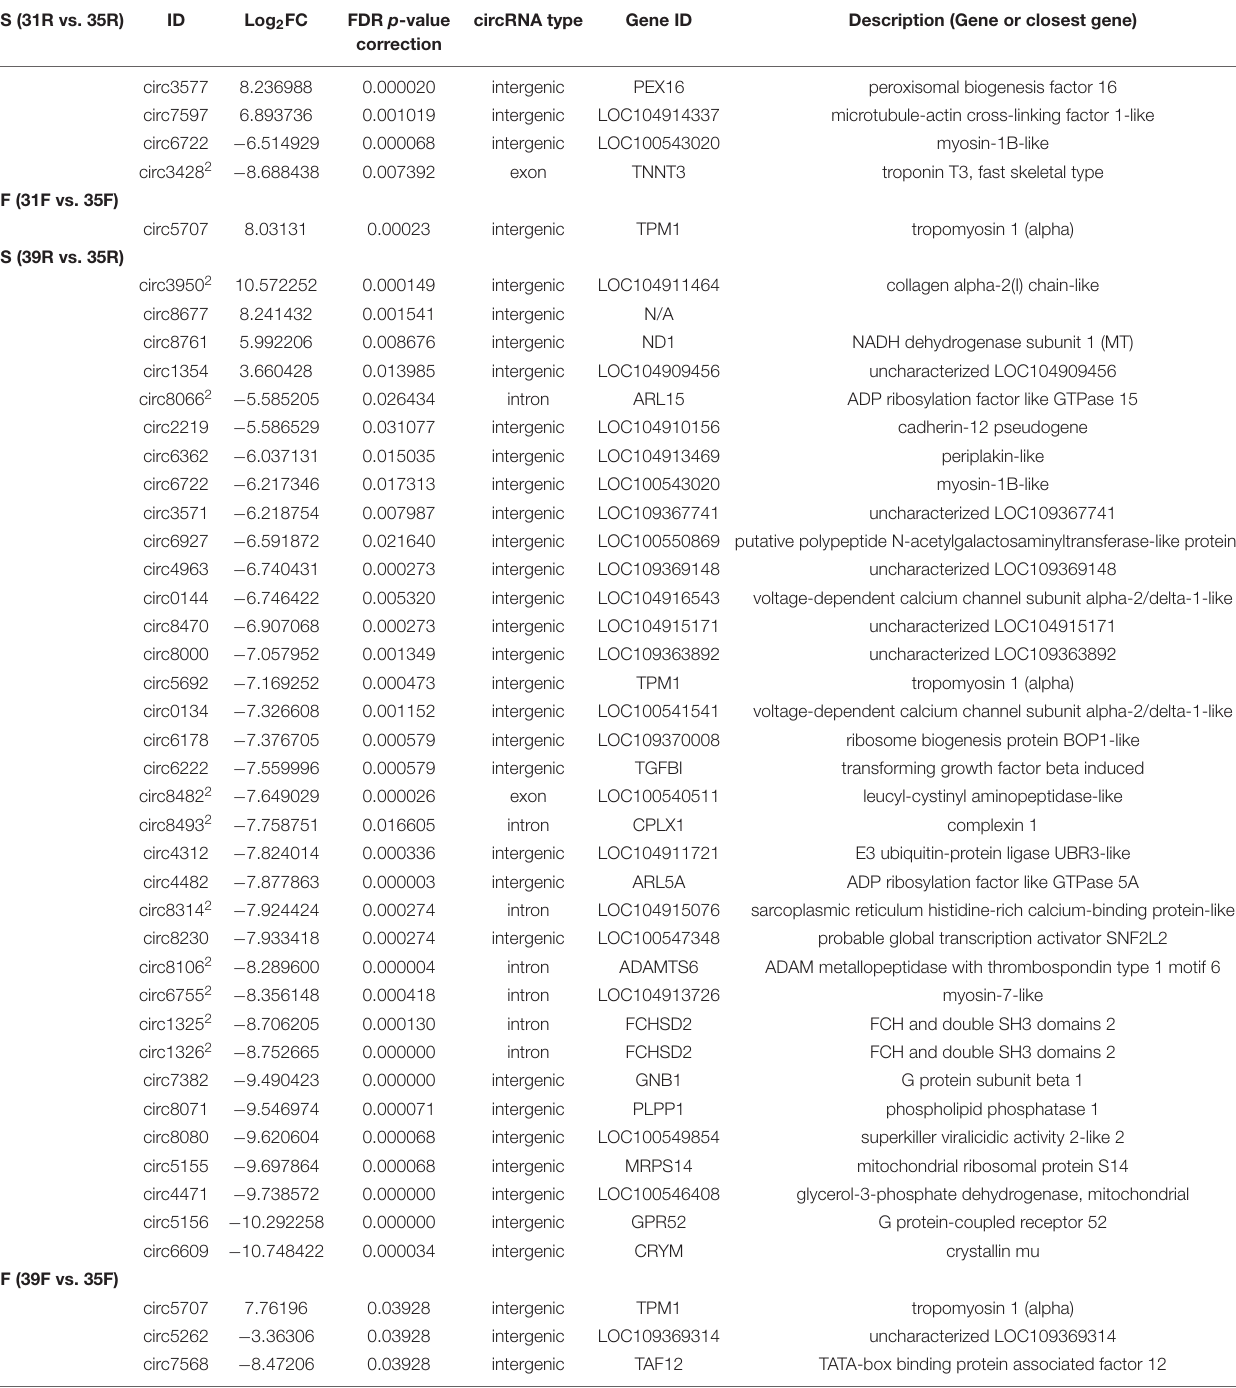
TABLE 3 | Significant differentially expressed circRNAs (FDR P < 0.05 and | Log 2 FC| > 2.0) in within-line treatment comparisons (see Figure 2A ) 1 . CS (31R vs.